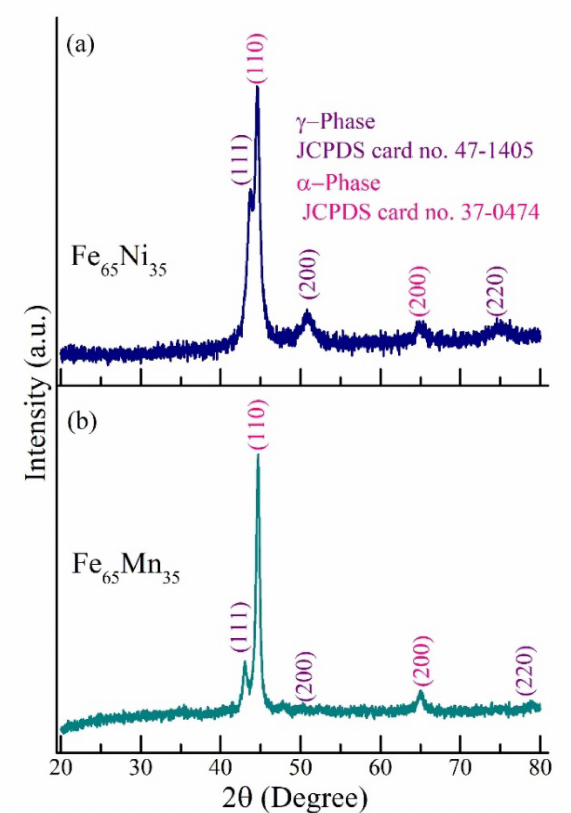
Figure 1. Room temperature X-ray diffraction pattern (XRD): ( a ) XRD results for Fe 65 Ni 35 ; ( b ) XRD results for Fe 65 Mn 35 .